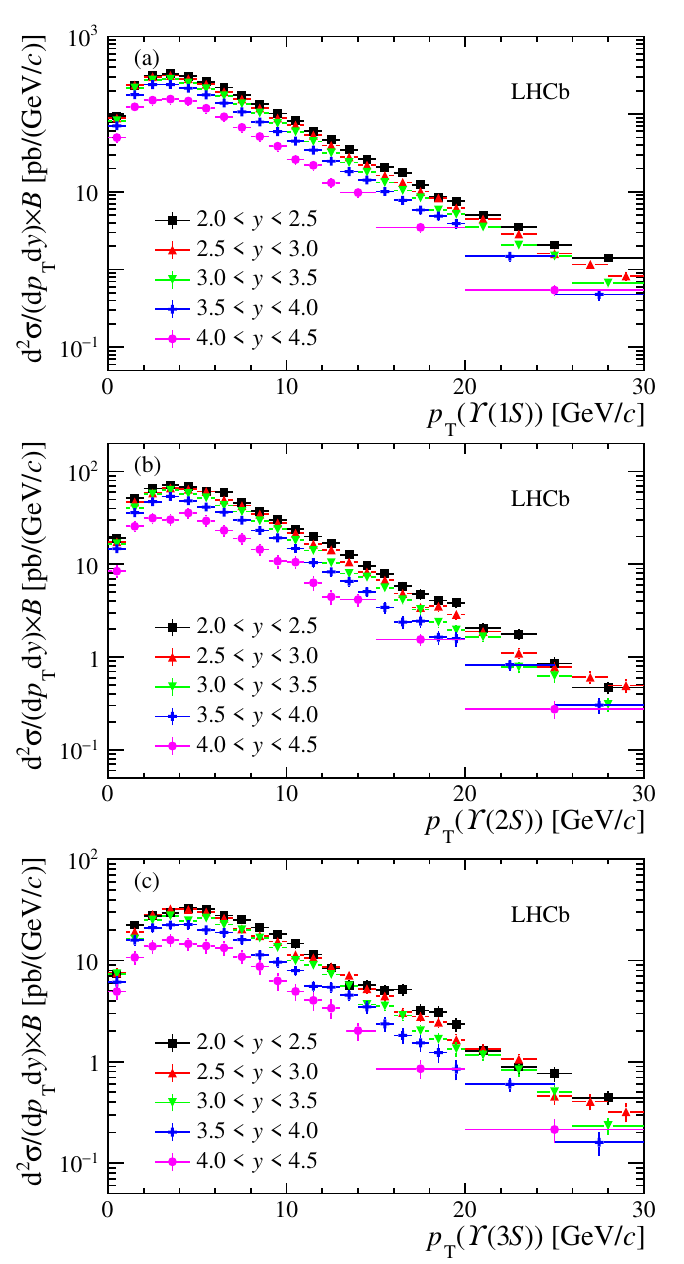
Figure 2 . Double-di(cid:11)erential cross-sections multiplied by dimuon branching fractions as a function of p T in intervals of y for the (a) (cid:7) (1 S ), (b) (cid:7) (2 S ) and (c) (cid:7) (3 S ) mesons. Statistical and systematic uncertainties are added in quadrature.